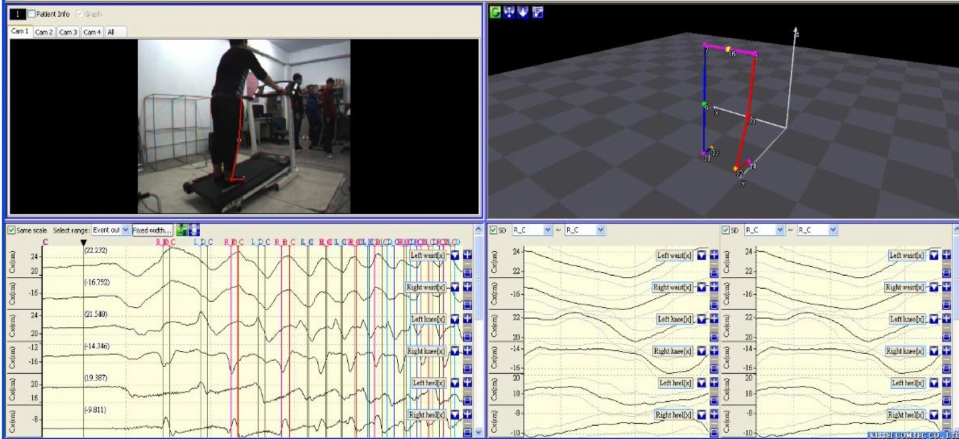
Figure 8. Process of capturing a gait cycle when a person walks in a 3D